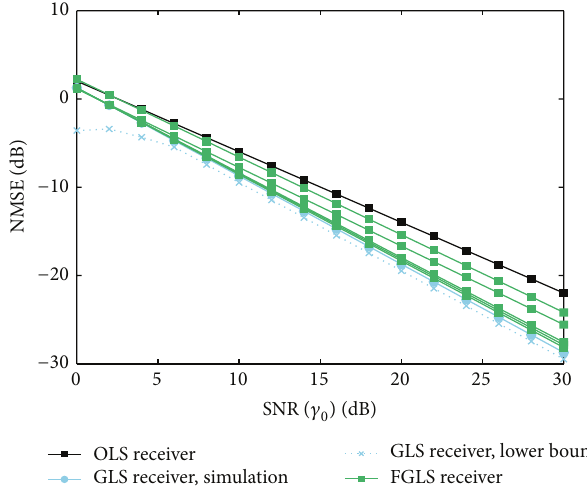
Figure 2: NMSE performance of OLS, GLS, and FGLS receivers.